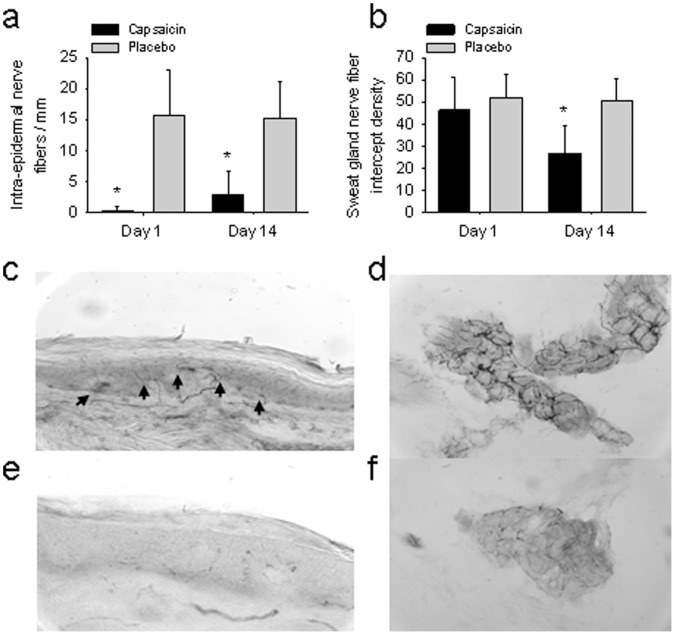
The intra-epidermal and sweat gland nerve fiber density in capsaicin and placebo treated skin.(a) The intra-epidermal nerve fiber density from biopsies taken on day 1 and 14 is shown (mean ± SD). *P<0.001 compared to control. (b) The sweat gland nerve fiber density from biopsies taken on day 1 and 14 is shown (mean ± SD). *P<0.01 compared to control. (c, e) Protein gene product 9.5 labeled intra-epidermal nerve fibers from day 14 biopsies in placebo (c) and capsaicin (d) treated skin. Black arrows denote intra-epidermal fibers in placebo treated skin (c), but are not seen in capsaicin treated skin (e). (d, f) Protein gene product 9.5 labeled sweat gland nerve fibers from day 14 biopsies in placebo (d) and capsaicin (f) treated skin.